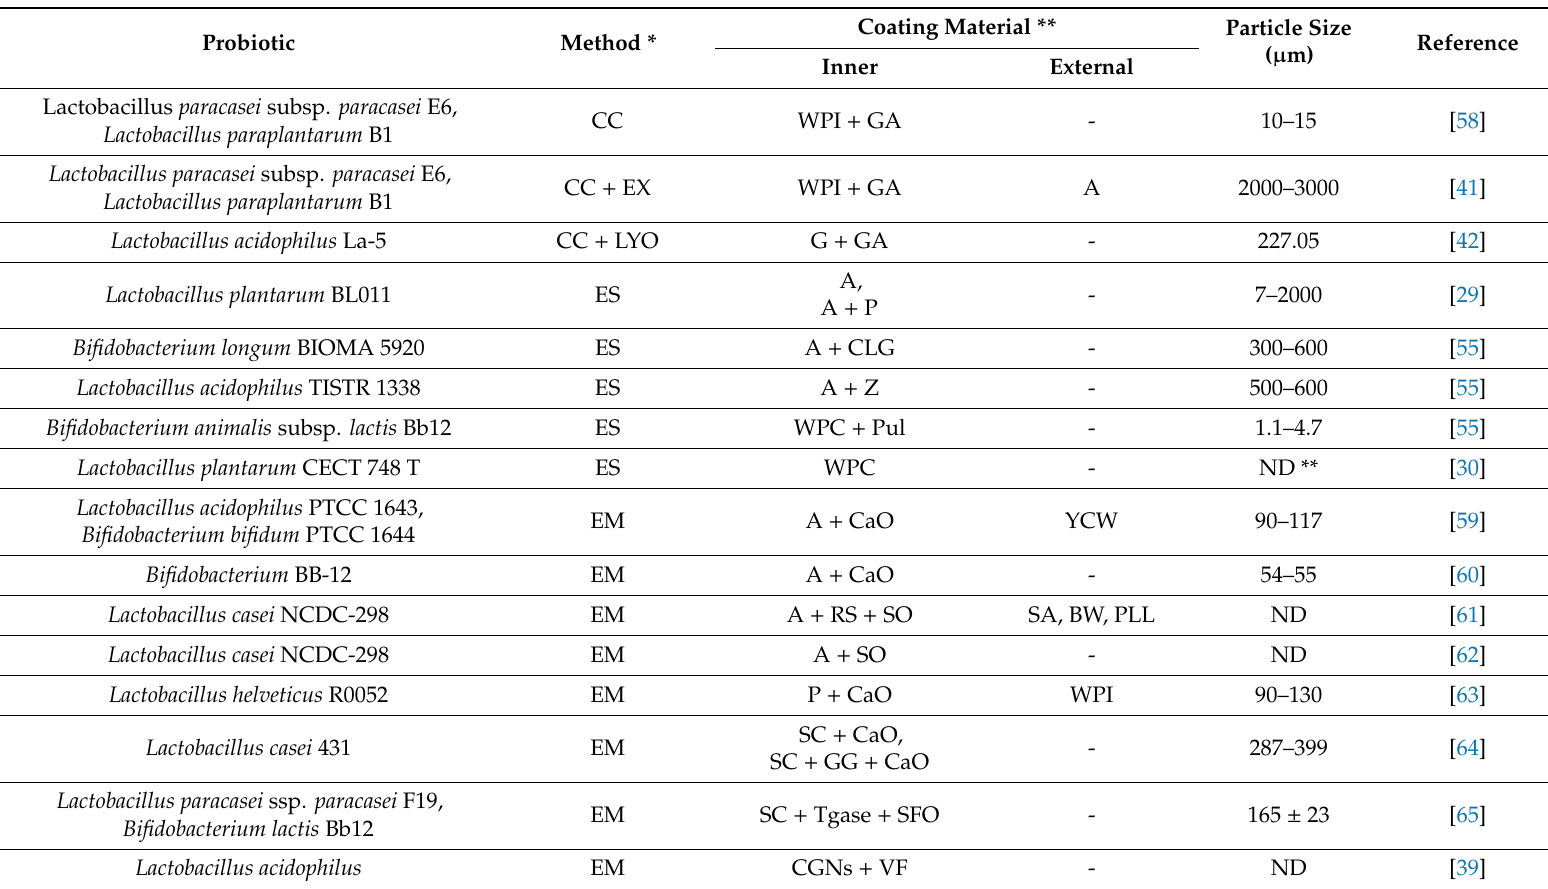
Table 1. Di ff erent works reporting the microencapsulation of probiotics. The table summarizes the probiotic microorganisms, the method of microencapsulation, and the coating material employed for the development of probiotic microcapsules, as well as the reported average particle